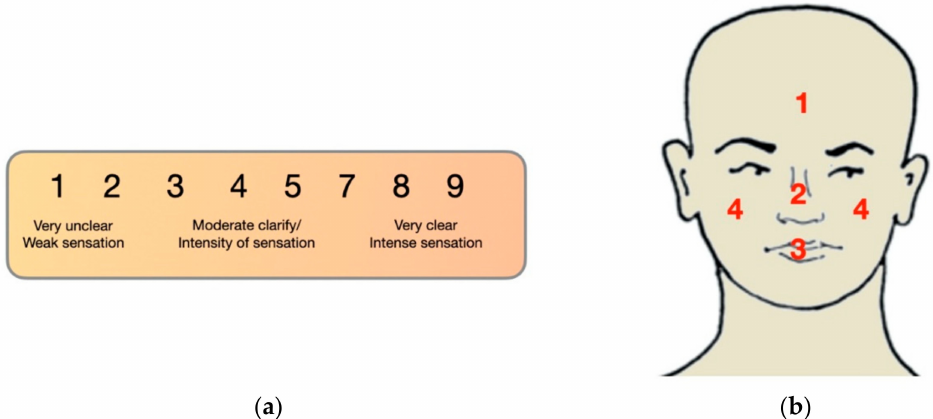
Figure 1. Individual face perception assessment. ( a ) Subjective Sensitivity Scale (SDSS) used during body scanning. ( b ) The subjective body (face) chart where the face is divided into 4 regions, defining the magnitude and localization of the face perception changes (modified after Fox et al.,